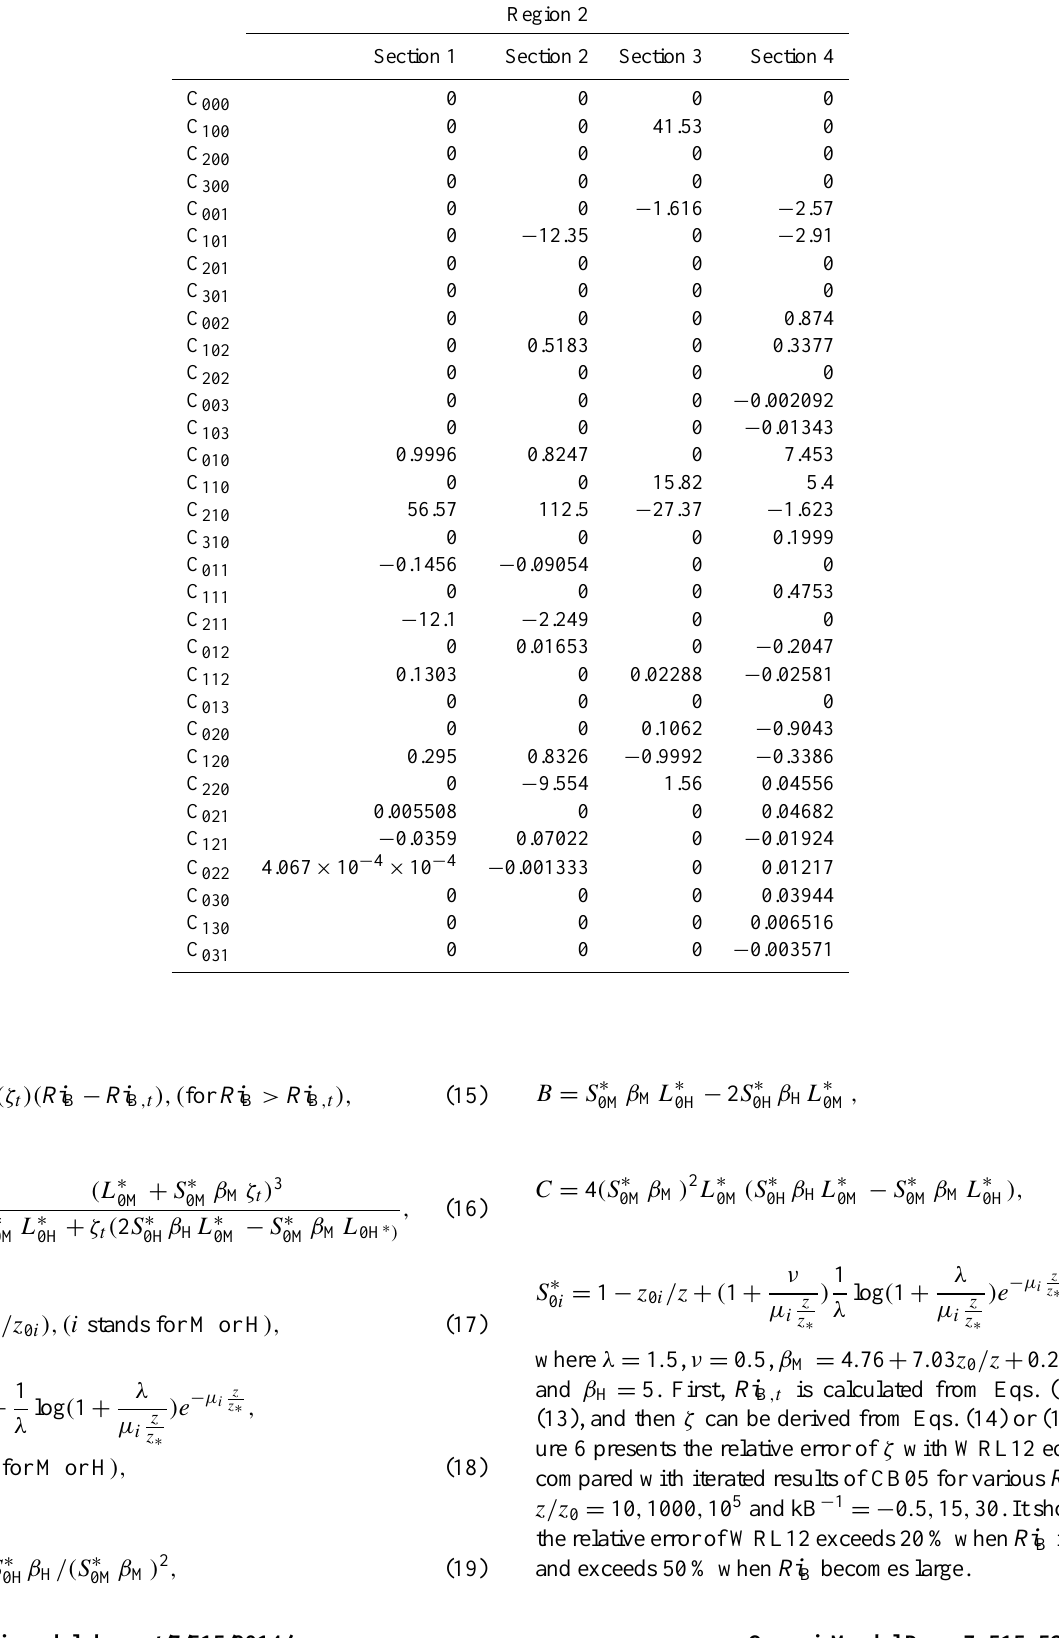
Table 4. Similar to Table 3, but for region